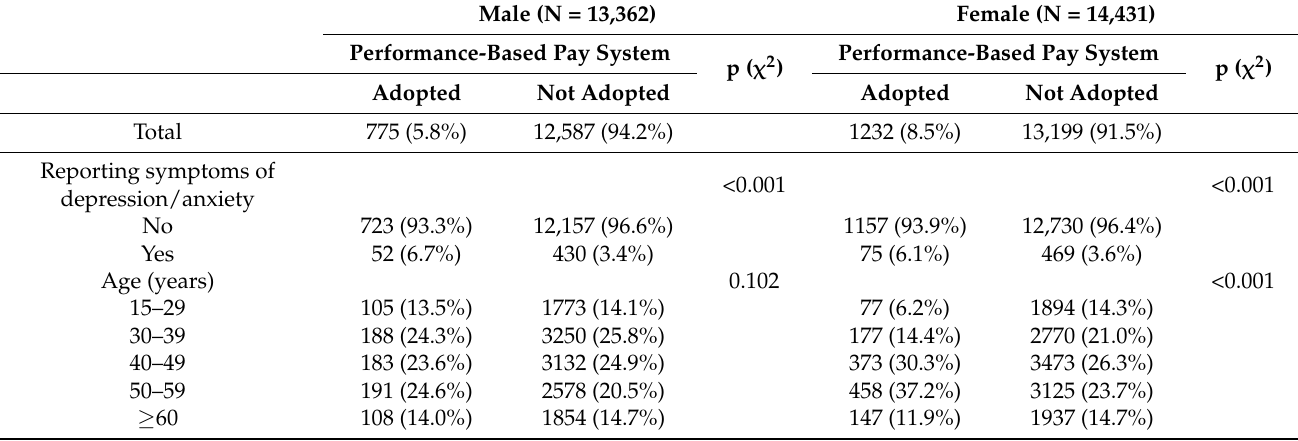
Table 1. General characteristics of the study population based on adoption of performance-based pay system and demographic